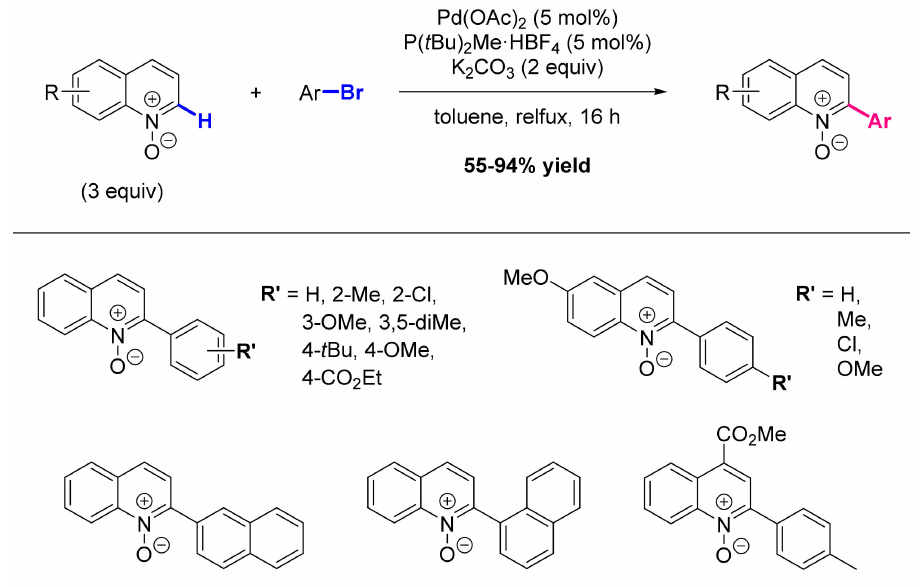
Scheme 6. Pd-catalyzed C2 arylation of quinoline N-oxides with aryl